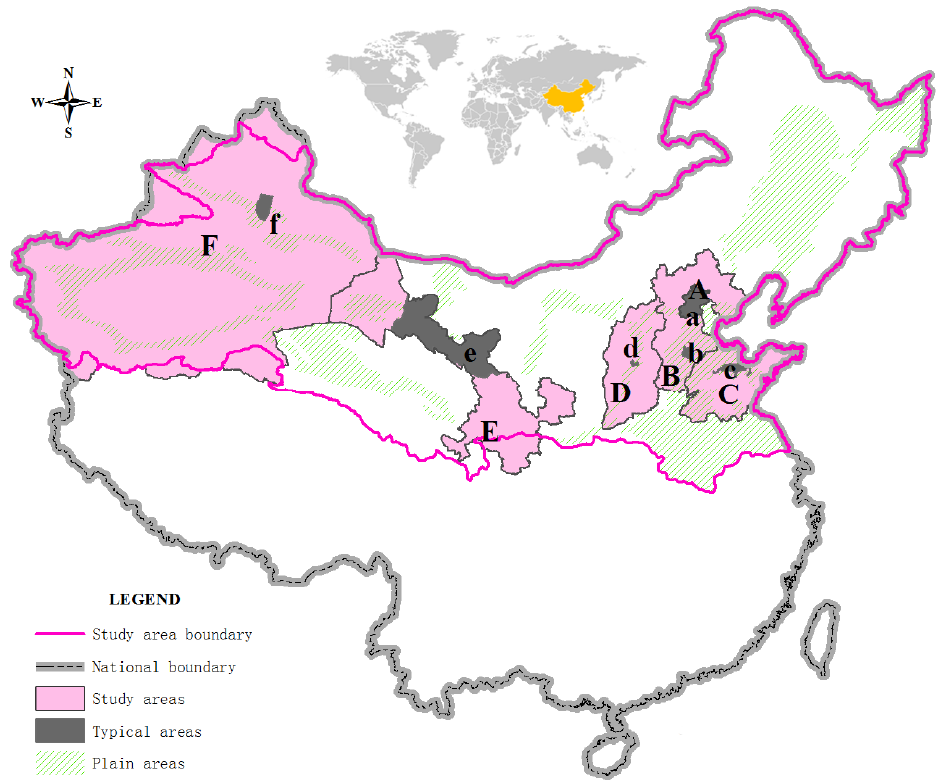
Figure 1. The northern China study area and the six selected provinces where groundwater over ‐ production occurred in typical plain areas. A—Beijing, B—Hebei Province, C—Shandong Province, D—Shanxi Province, E—Gansu Province, F—Xinjiang Province, a—entirely covers Beijing, b—Taocheng County and Shenzhou County of Hengshui City, c—Zibo ‐ Weifang groundwater depression cone, d—Qingxu County,